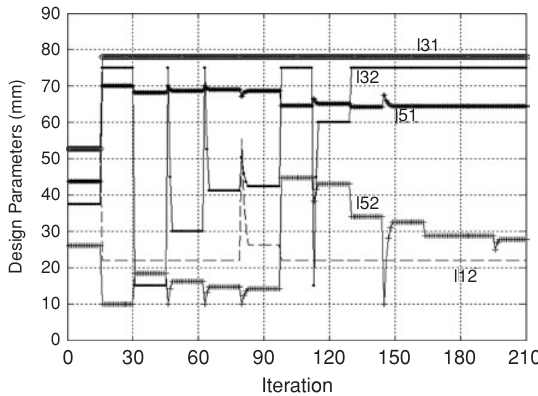
Figure 15 Evolution of design parameters l 31 , l 32 , l 51 , l 52 , l 12 .